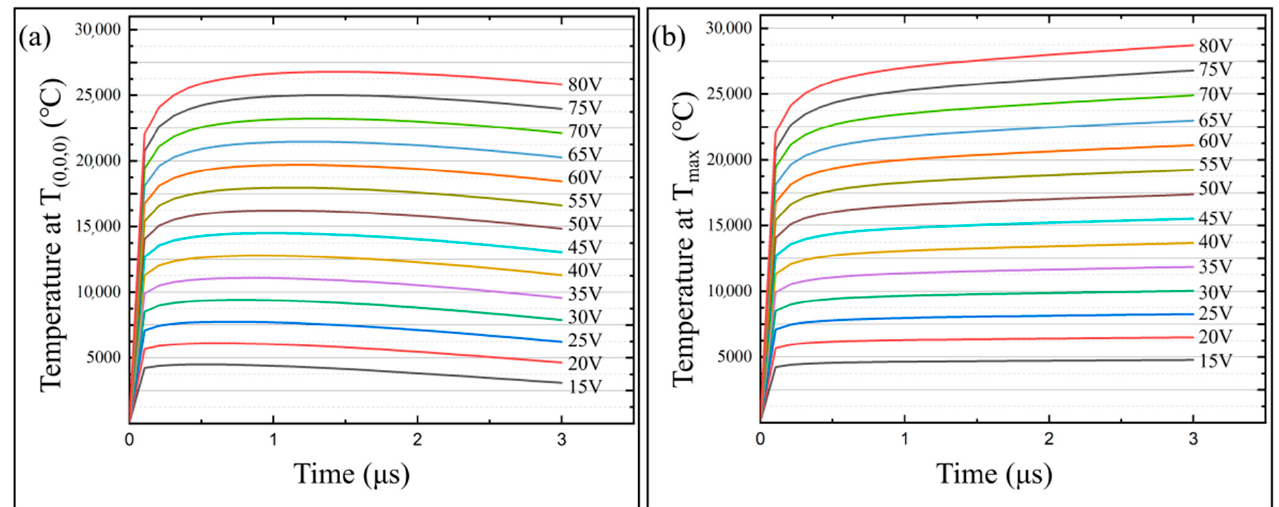
Figure 10. ( a ) T (0,0,0) variation with machining time at different machining voltages; ( b ) t max variation with machining time at different machining voltages.